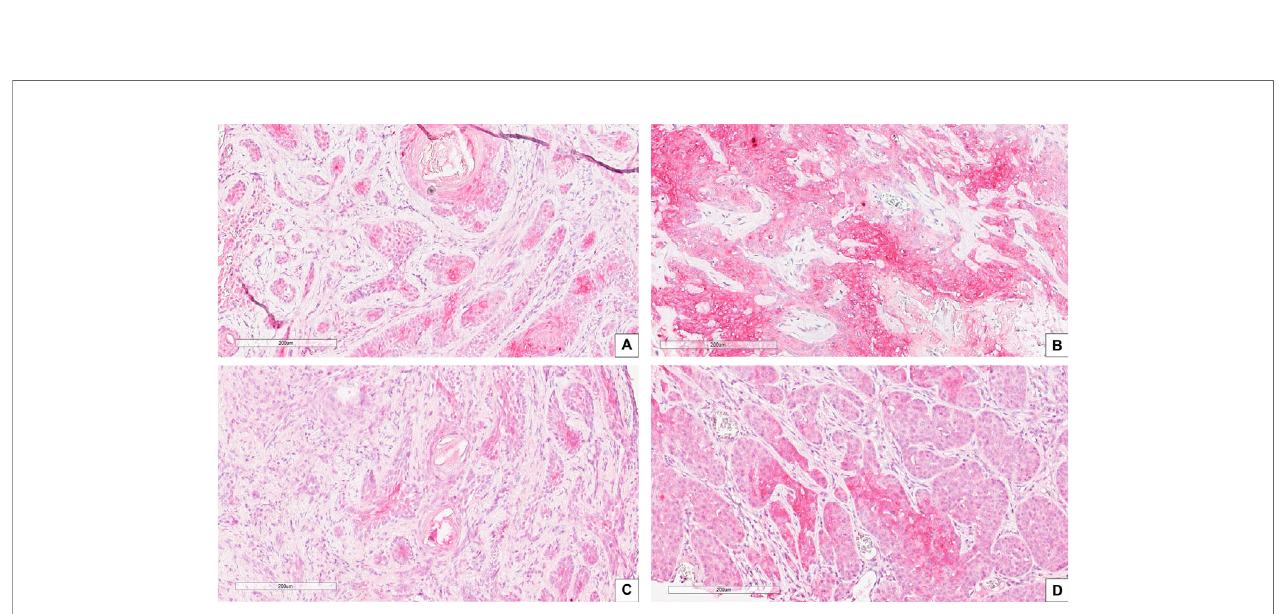
FIGURE 3 | IHC stain with an anti-CAIX antibody in high risk BCC histological variants: (A) In fi ltrating BCC; (B) Morpheaform BCC; (C) Micronodular BCC; (D) Basosquamous BCC. Scale bars are shown, magni fi cation is 20×.